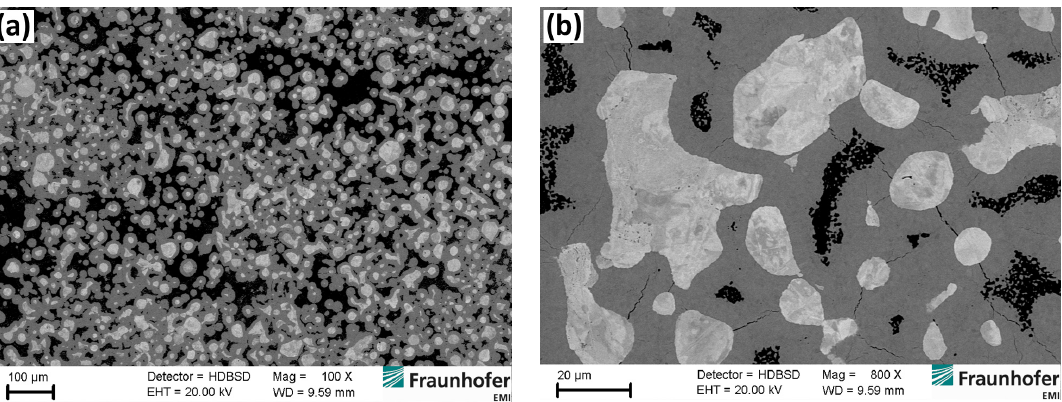
Figure 6. Backscatter images of a metallographic specimen after heat treatment (1200 °C, 1 h). ( a ) Overview at low magnification; ( b ) Close-up revealing the formation of an interphase exhibiting cracks probably caused by thermal stress relief.